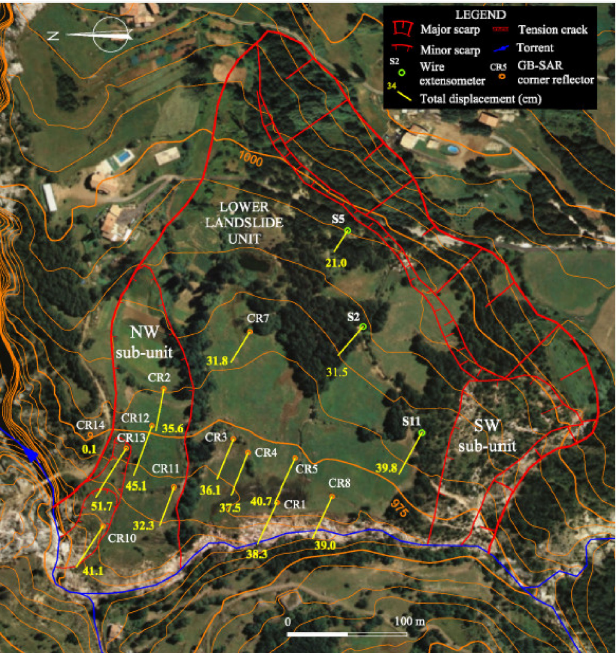
Figure 27. Displacement field of the lower unit of the Vallcebre landslide reconstructed using GBSAR CRs and borehole wire extensometers (S). The yellow figures, in cm, are the total displacements observed from February to November 2010